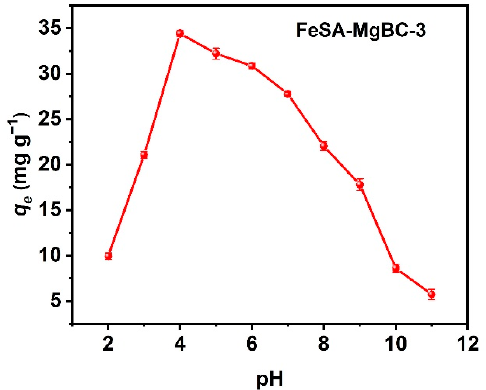
Figure 5. q e for PO 4 -P at different pH values of FeSA-MgBC-3.